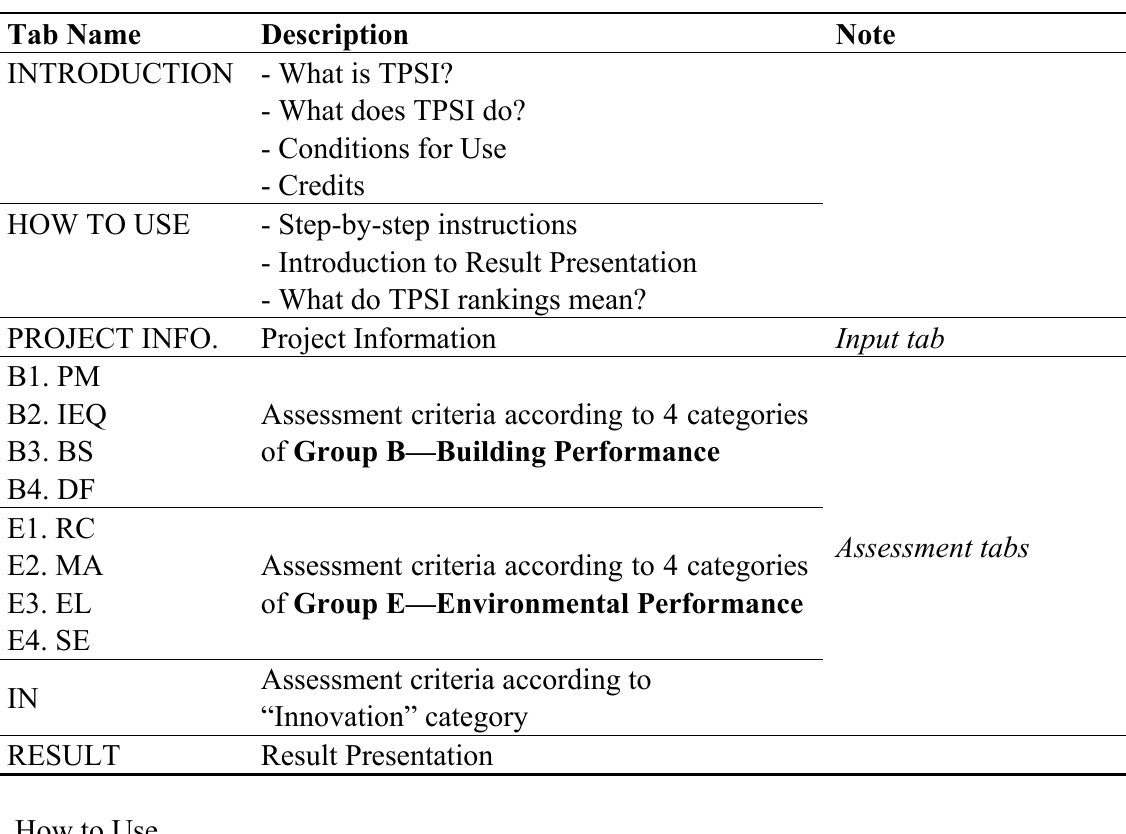
Table 3. Summary of TPSI Calculator’s